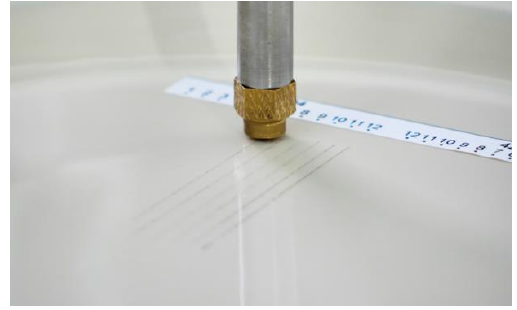
Figure 15. CTCV metal marking test on a porcelain dish.